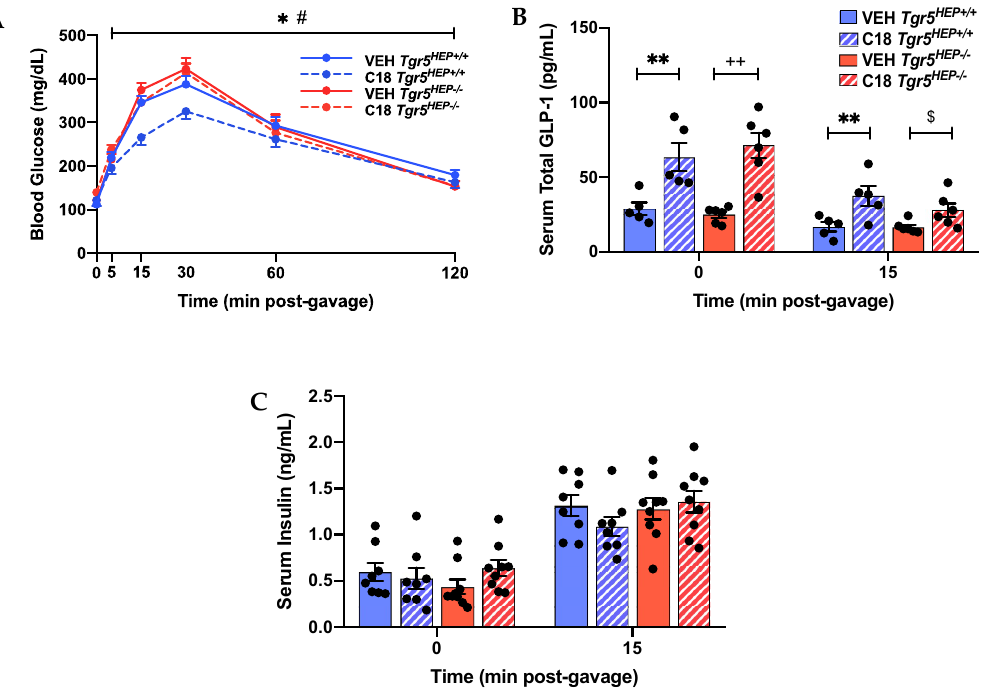
Figure 3. Compound 18 improves glucose regulation in a hepatocyte TGR5-dependent manner. ( A ) Blood glucose, ( B ) serum total GLP-1, and ( C ) serum insulin concentrations during an OGTT in Tgr5 HEP +/+ and Tgr5 HEP − / − mice after 3 doses of Compound 18 (C18) or vehicle (VEH). n = 5–9. * p < 0.05, ** p < 0.01 C18 Tgr5 HEP +/+ vs. VEH Tgr5 HEP +/+ ; ++ p < 0.01 C18 Tgr5 HEP − / − vs. VEH Tgr5 HEP − / − ; # p < 0.05 C18 Tgr5 HEP − / − vs. C18 Tgr5 HEP +/+ by two-factor ANOVA; $ p < 0.05 compared with VEH Tgr5 HEP − / − by Student’s t